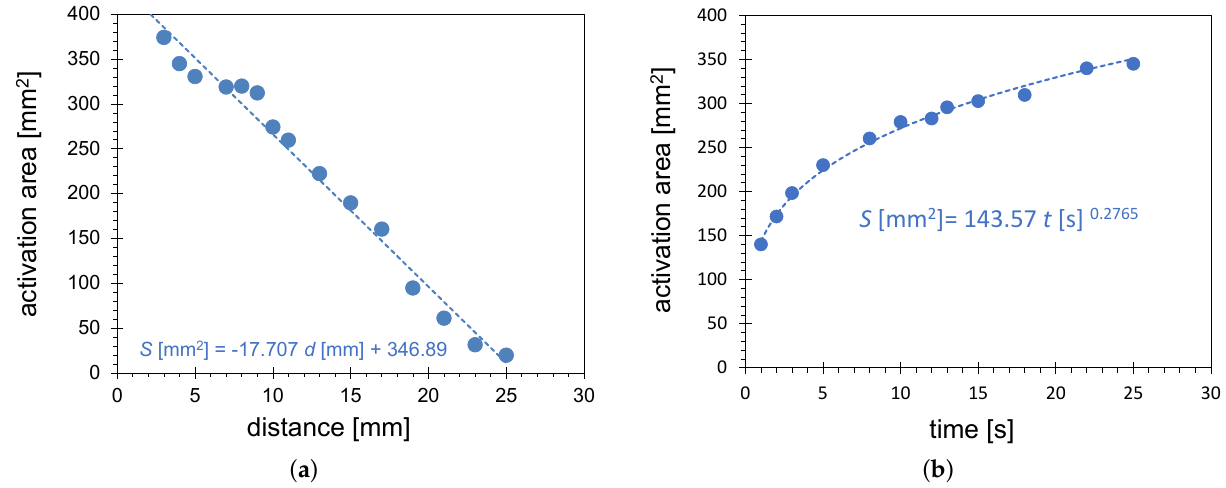
Figure 22. The activation area of piezobrush ® PZ3 multi-gas nozzle for argon as a function of ( a ) distance, and ( b ) treatment time. Power level: 8 W, gas flow: 3.0 SLM, treatment time: 10 s. Visualization of activation area with 58 mN/m test ink on